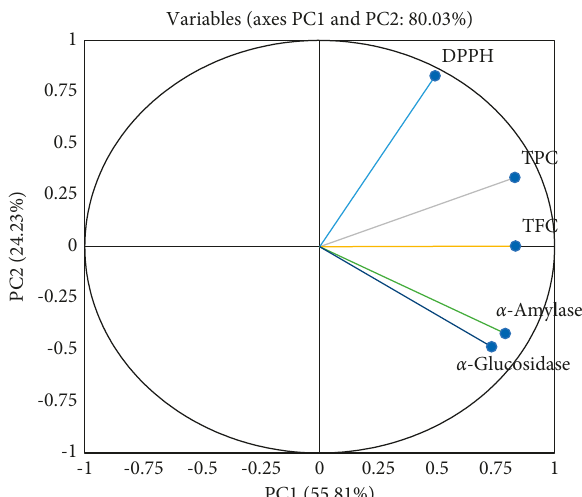
Figure 2: Loading plot of phytochemical content and pharma- cological parameters.